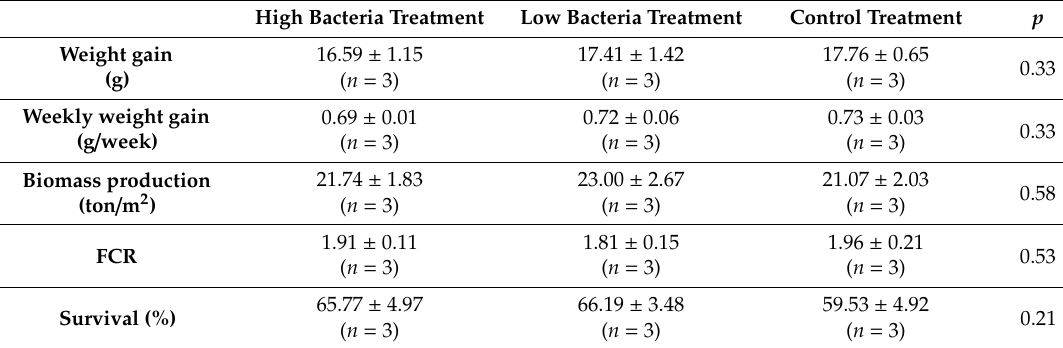
Table 2. Mean and standard deviation of the growth parameters for high bacteria treatment indicated for each treatment.